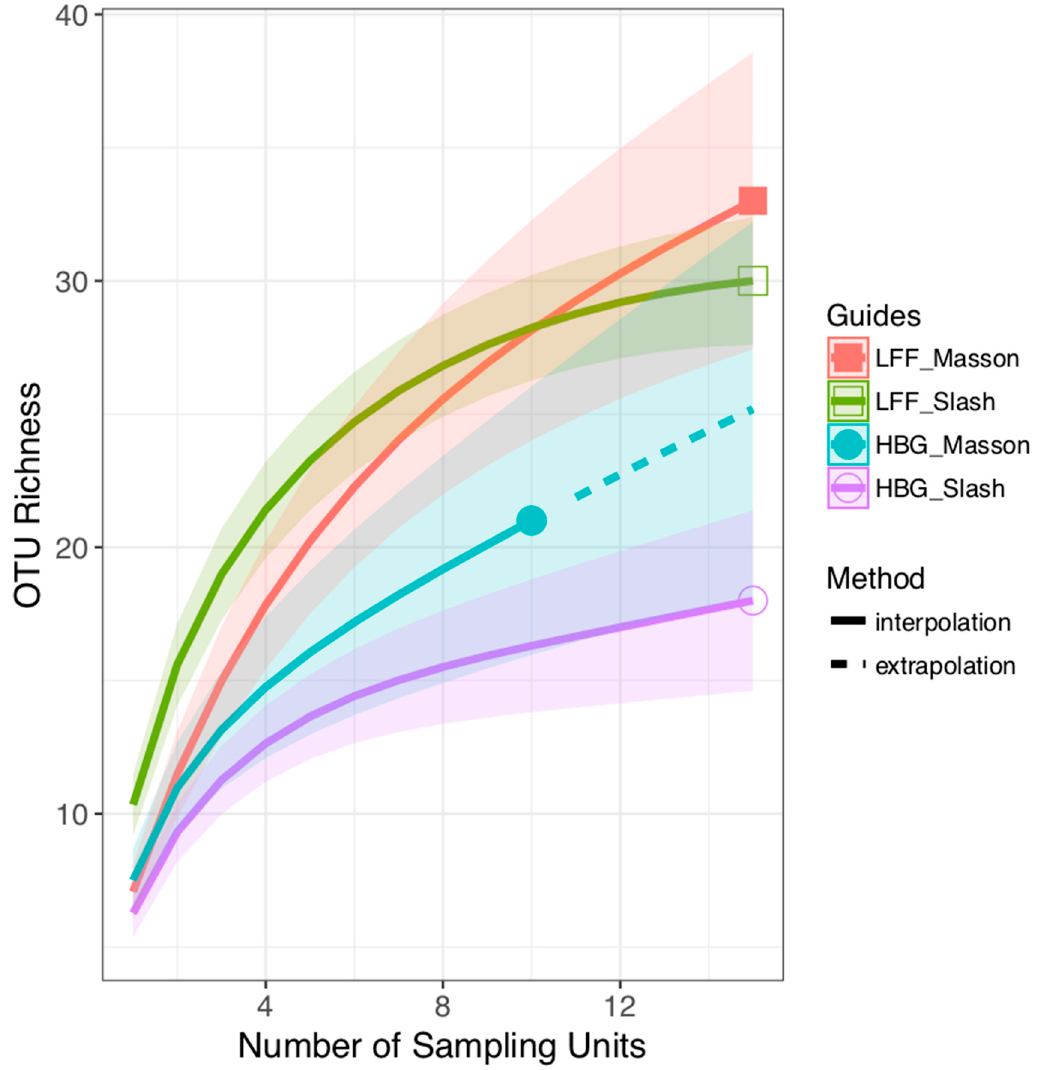
Figure 3. Sample-size-based species accumulation rarefaction (solid line segment) and extrapolation (dotted line segments) sampling curves with 95% confidence intervals (shaded areas) for estimated total ectomycorrhizal OTU richness across different host/sites. LFF—Longli Forest Farm; HBG—Hunan Botanic Garden.